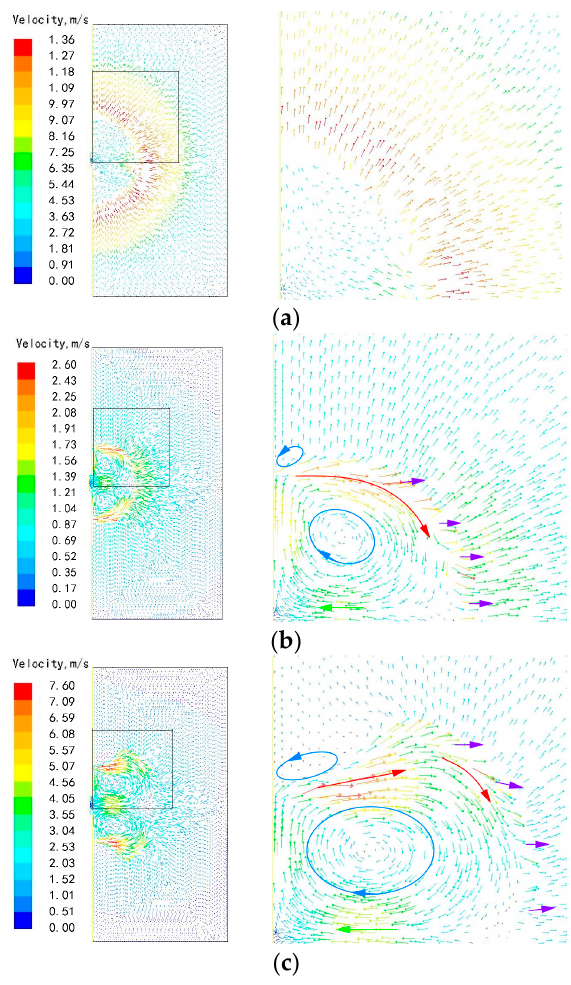
Figure 7. Velocity vector in simulation: ( a ) 0 kV; ( b ) − 2.5 kV; and ( c ) − 5 kV.